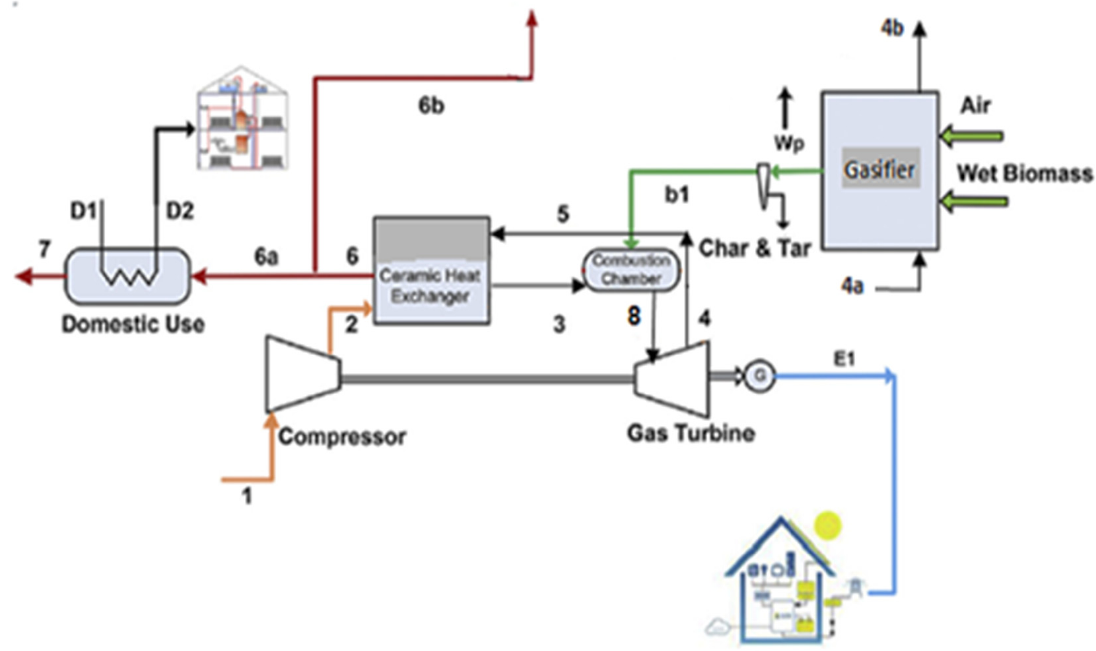
Figure 1. The regenerative gas turbine cycle integrated with the Biomass Gasifier Unit.